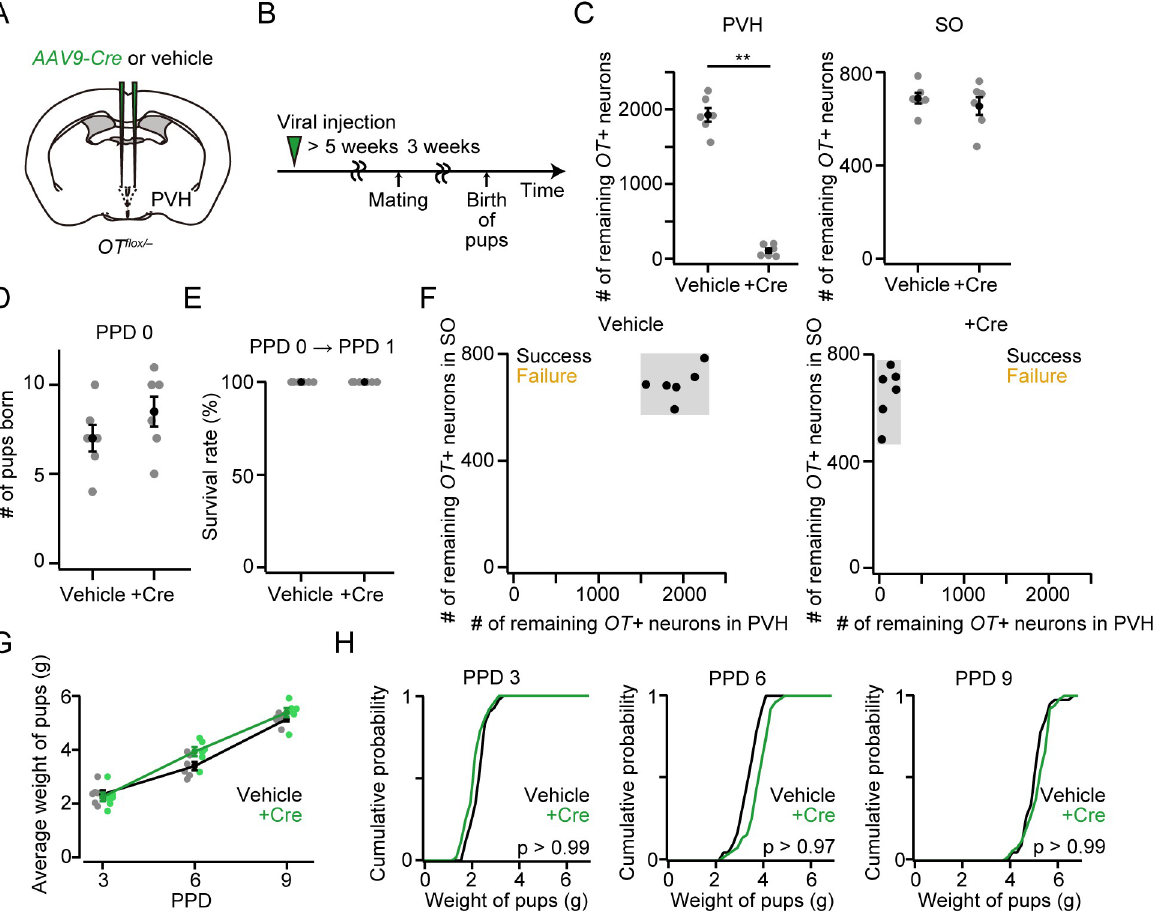
Fig 6. OT expression in the PVH does not affect the survival of pups. (A) Schematic of the viral injection. AAV-Cre or vehicle was injected into the bilateral PVH. (B) Schematic of the timeline of the experiment. (C) Number of remaining OT + neurons in the PVH (left) or SO (right). �� p < 0.01, two-sided Mann–Whitney U- test. n = 6 and 6 mothers for vehicle and +Cre, respectively. (D) The number of pups born was not statistically different (p > 0.26, two-sided Mann–Whitney U- test). No dead pups were found. n = 6 and 6 mothers for vehicle and +Cre, respectively. (E) Survival rate of pups at PPD 1. (F) Relationship between the success (black dots) or failure (orange dots) of raising pups at PPD 1 and the number of remaining OT+ neurons in the PVH (x-axis) or SO (y-axis). Data from the same mice shown in C. (G) Average weight of pups per dam. No statistical difference was found in vehicle and +Cre (two-way ANOVA with repeated measurements). n = 6 and 6 for vehicle and +Cre, respectively. (H) Cumulative probability of weight of pups in PPD 3, PPD 6, and PPD 9. The p-value is shown in the panel (Kolmogorov– Smirnov test). n = 41 and 51 pups from 6 and 6 mothers for vehicle and +Cre, respectively. Error bars, standard error of the mean.